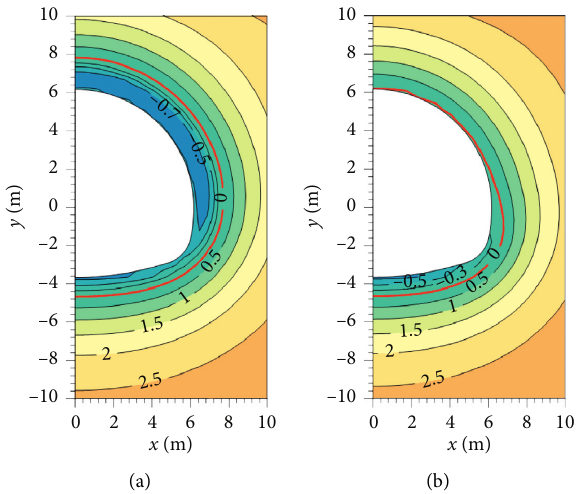
Figure 8: Thermal regimes of SR at D1 in (a) WTIL and (b) STIL on April 15 in 5 years of the operation period of the tunnel.